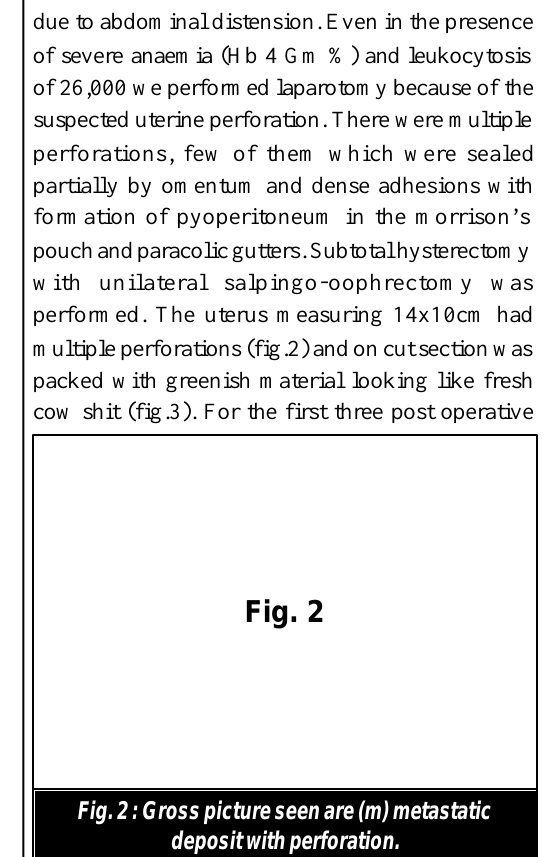
Fig. 2 : Gross picture seen are (m) metastatic deposit with perforation.